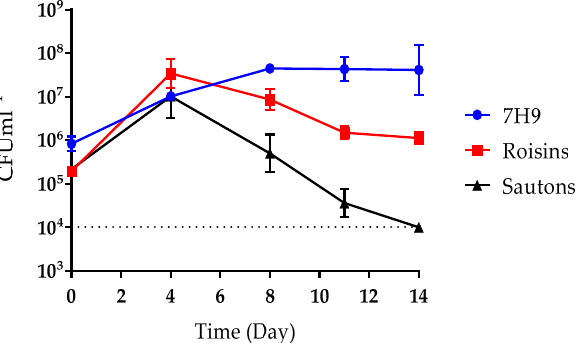
Figure 1. The total viable counts of M. bovis Bacillus Calmette–Guérin (BCG) flask grown in 50 mL of Middlebrook 7H9, Roisin’s minimal medium, or Sauton’s minimal medium, over 14 days. Culture in 250 mL vented Erlenmeyer flasks shaking at 200 RPM at 37 °C. 100 µL samples were taken, a 10-fold dilution series performed and spotted onto 7H10 + 10% OADC agar using the Miles and Misra method. Plates were incubated for three weeks at 37 °C and then colonies enumerated. The dotted line represents the limit of detection (1 × 10 4 CFU mL − 1 ). Data represent the mean average of three biological repeats ± standard error.